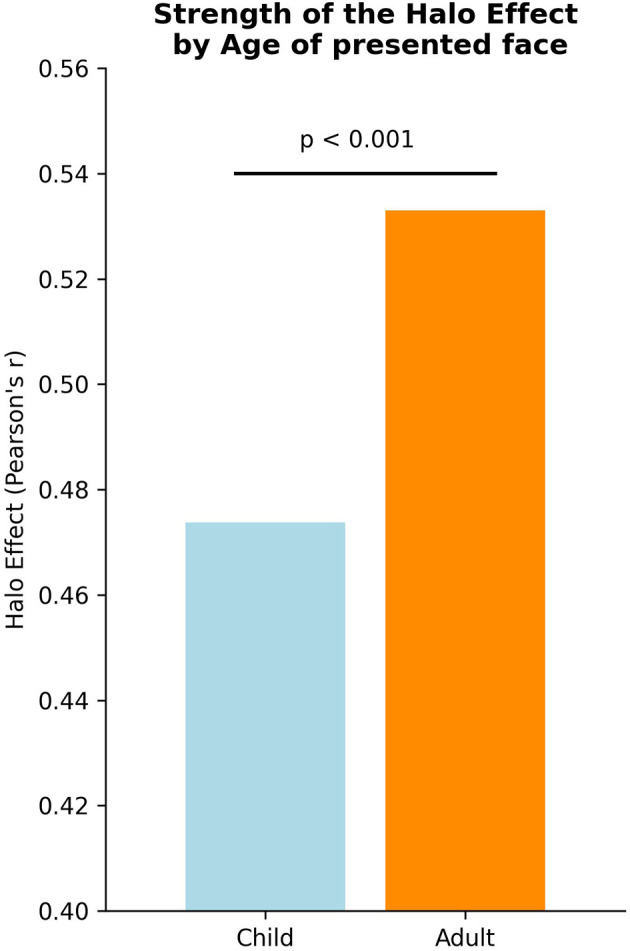
Strength of the halo effect (pearson-r) by age.